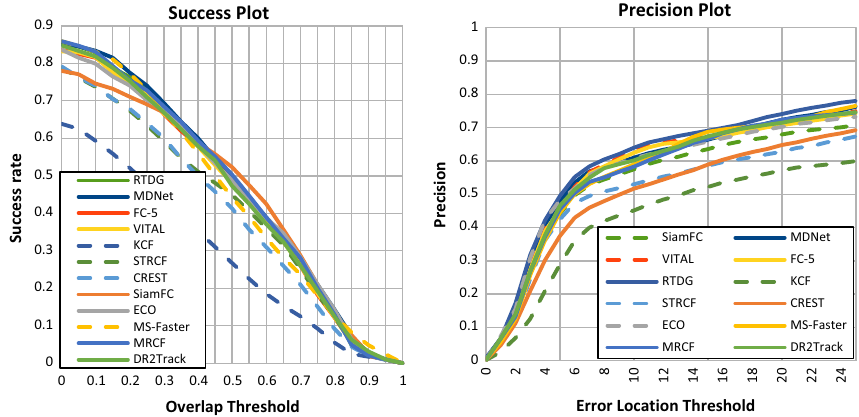
Fig. 12 Precision and success plots on the UAVDT dataset using OPE